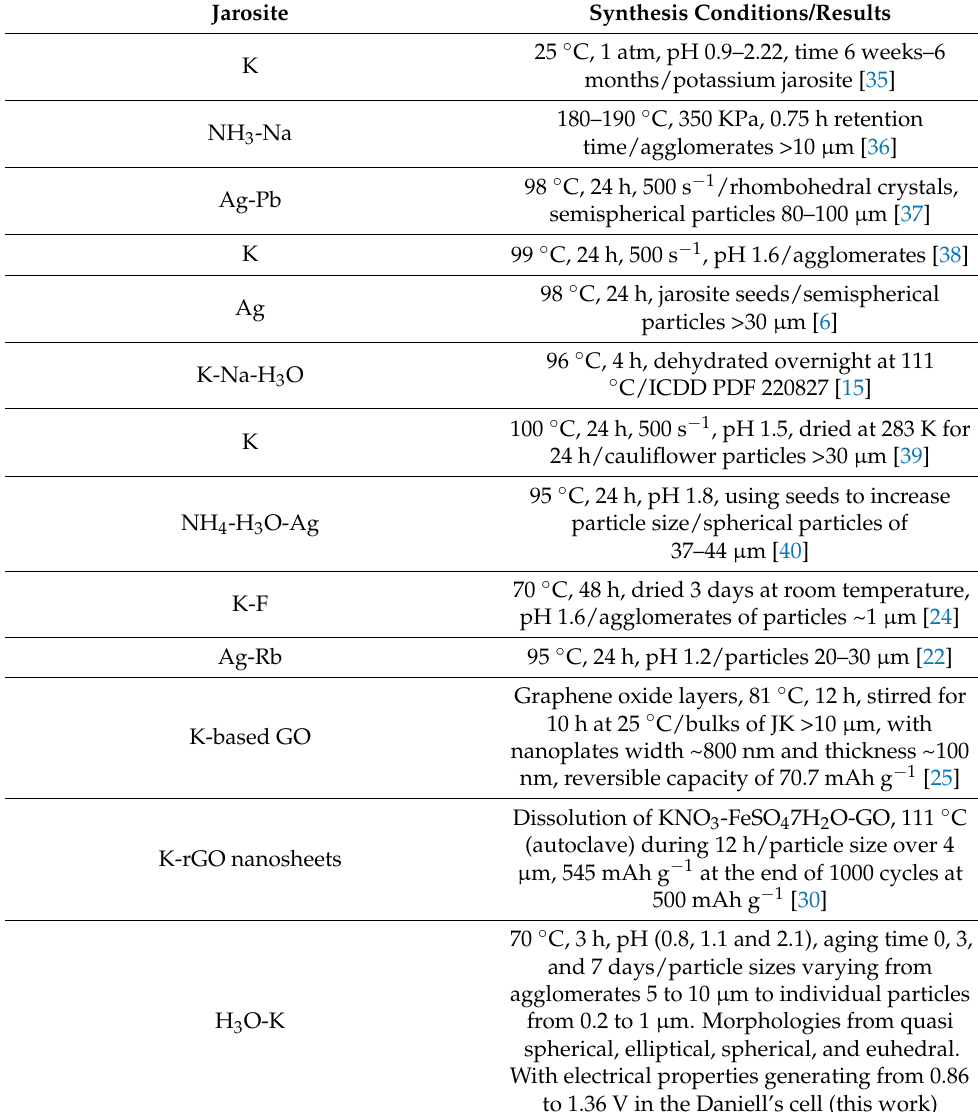
Table 6. Comparative description of some previous works related to the synthesis of jarosite type compounds and their